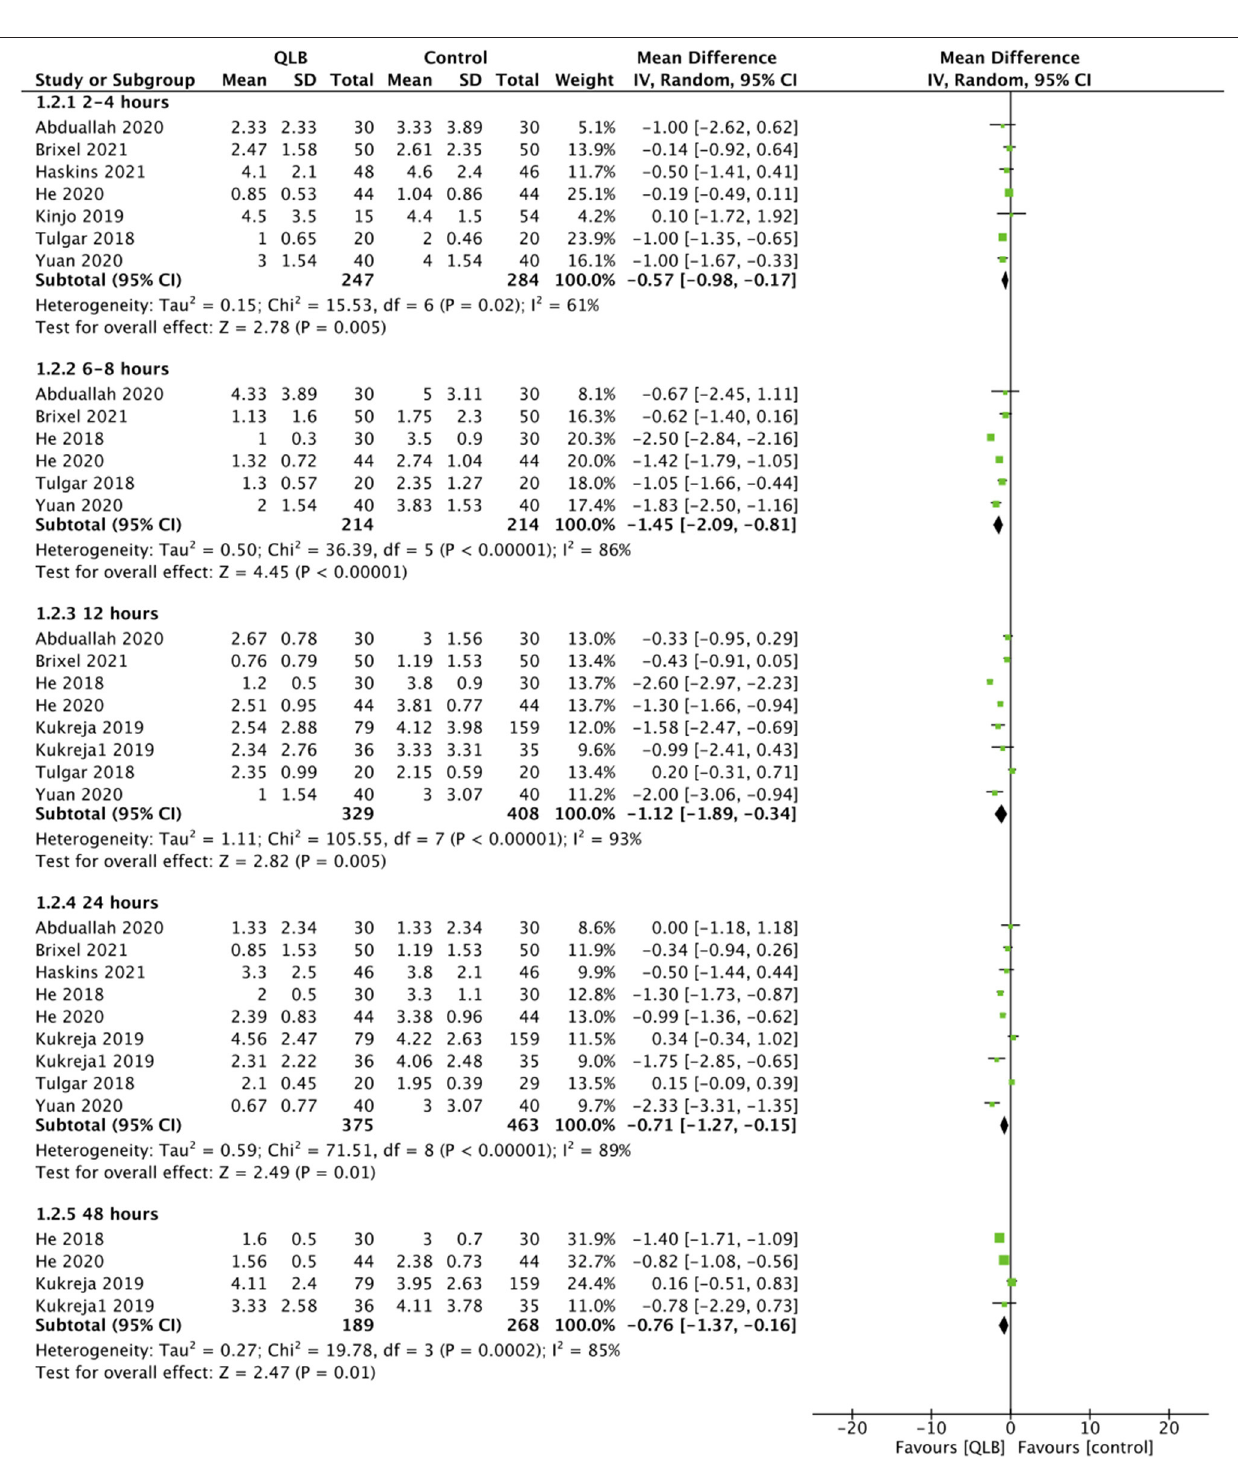
24-h opioid consumption with QLB on a pooled analysis of studies mostly on cesarean sections, renal or abdominal